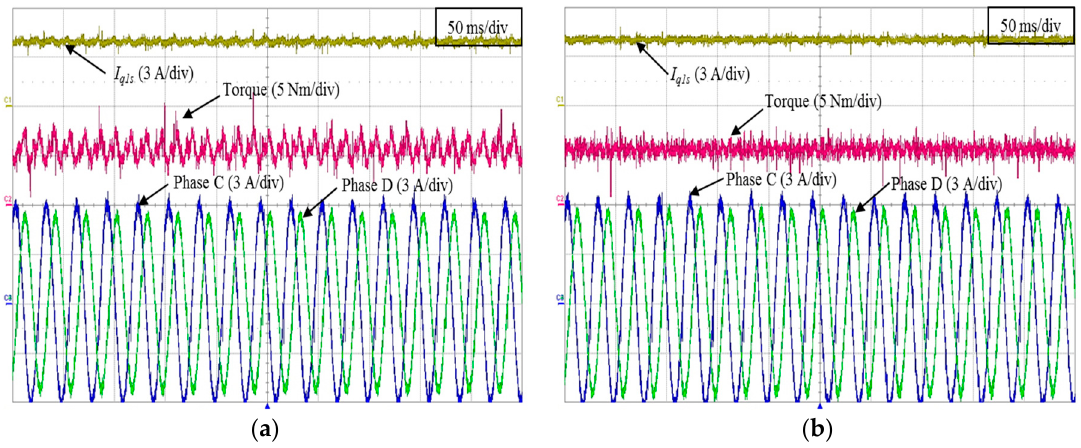
Figure 19. Experimental result of fault ‐ tolerance under open fault phases B in i q1s = 4 A and 1000 rpm: ( a ) Without tolerant control; ( b ) With tolerant control.